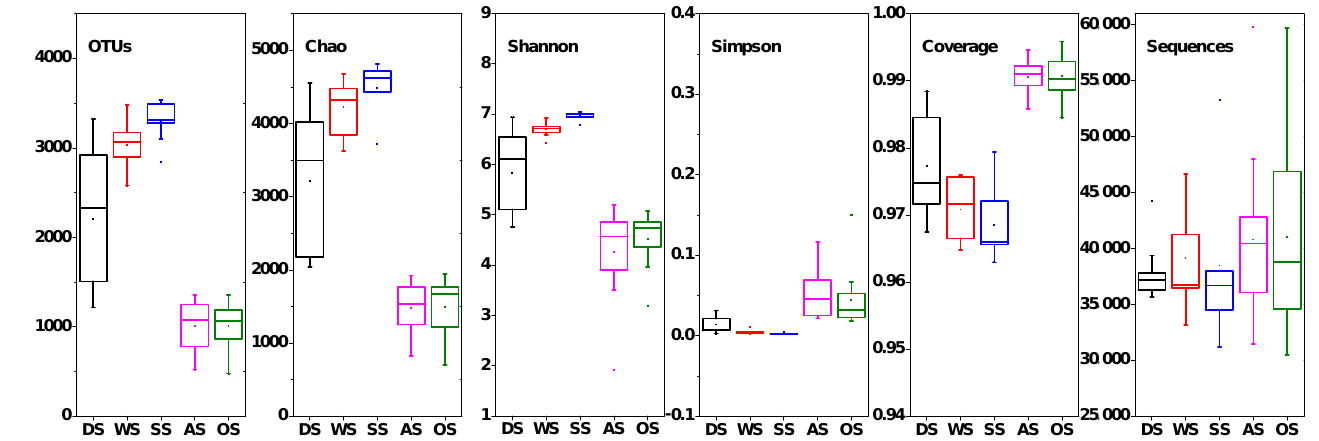
Figure 3. Boxplot of sample: α diversity in seawater and beach sand in Jinshitan bathing beach. DS represents dry sand; WS represents wet sand; SS represents submerged sand; AS represents alongshore seawater; OS represents offshore